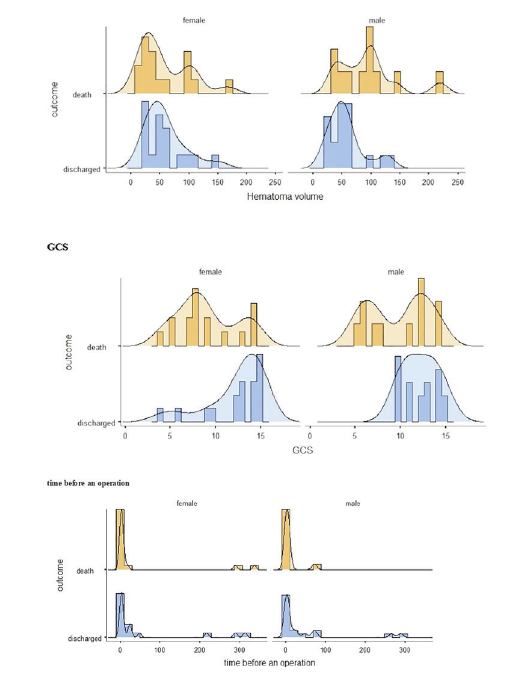
Figure 2 - Correlation between hematoma volume, CGS, time before operation and anatomical localization and an outcome